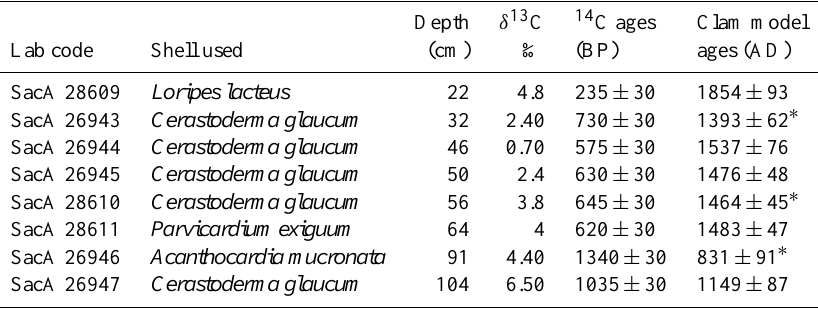
Table 1. 14 C data for mollusk shells from MC45. 14 C ages are calibrated using the Marine13 calibration curve with reservoir age (cid:49)R of − 218, model Ages were obtained by the “clam” R-code package.